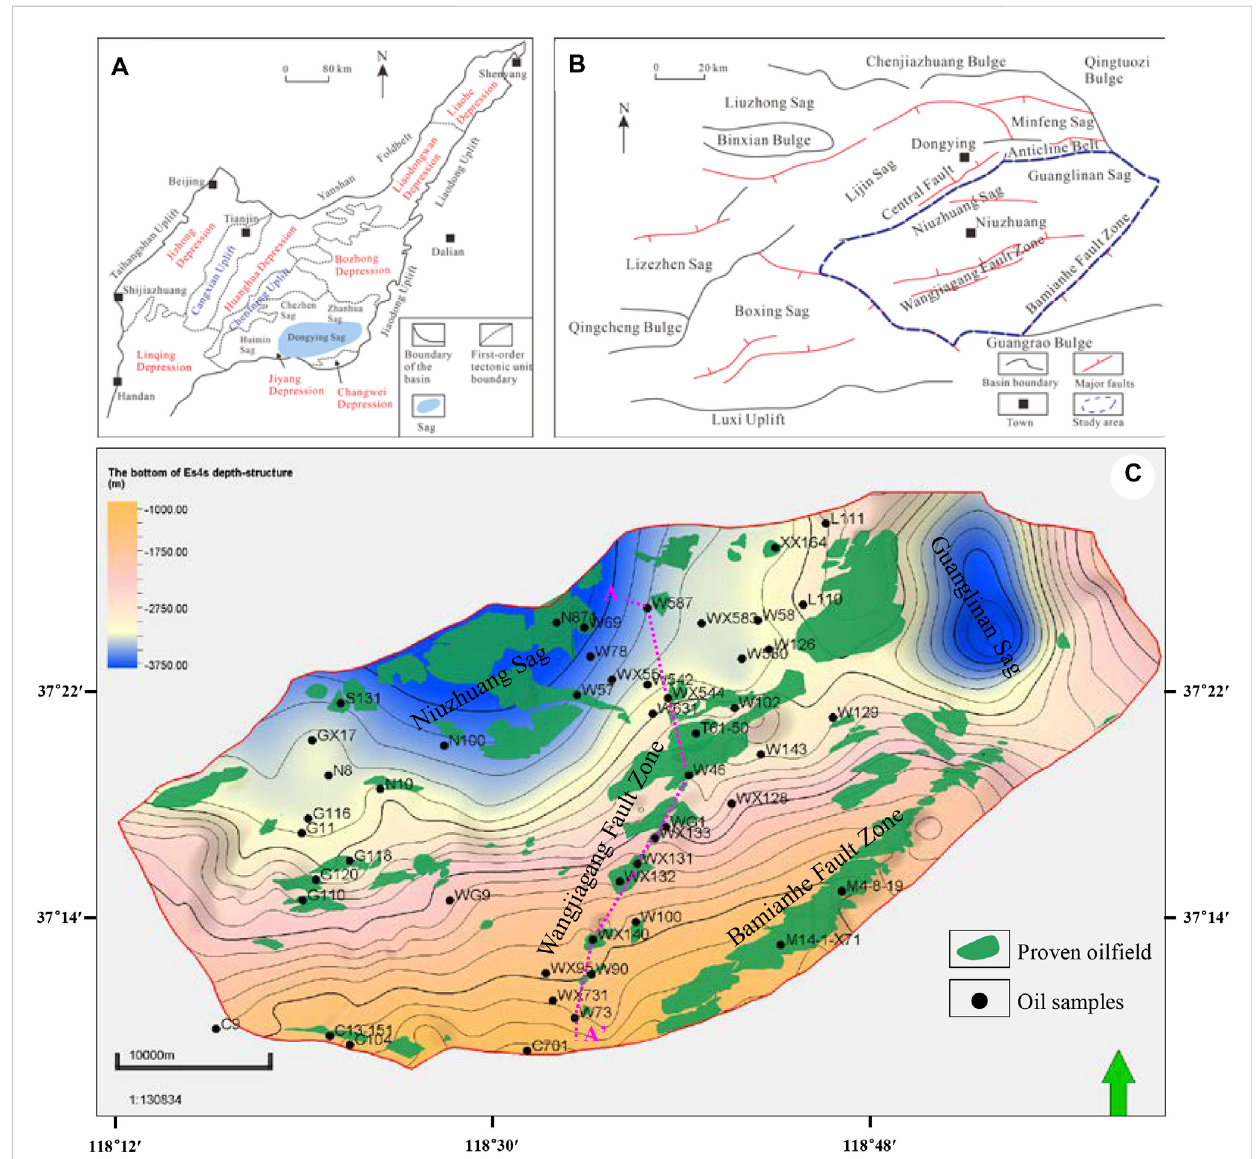
FIGURE 1 Geologicalmapofthestudyareaandoilsamples. (A) LocationmapoftheDongyingSag(revisedfromWangetal.,2019); (B) Themajortectonicunits in the Dongying Sag (revised from Shi et al., 2021); (C) Bottom the Es4s member depth structure map and oil sample location in the study